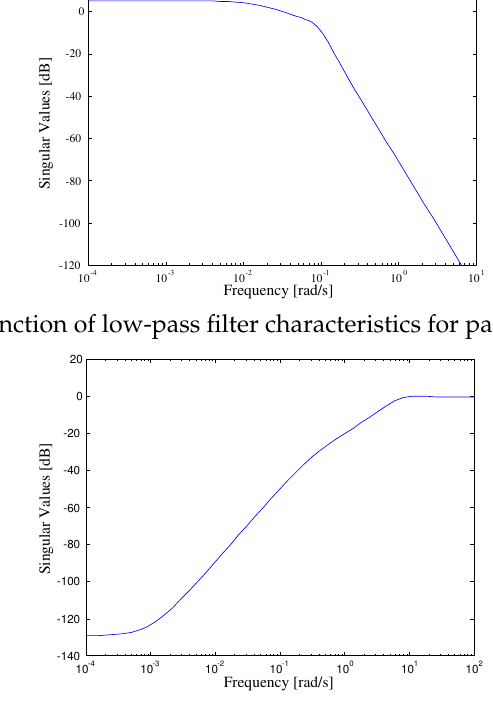
Figure 6. Weighting function of observer.